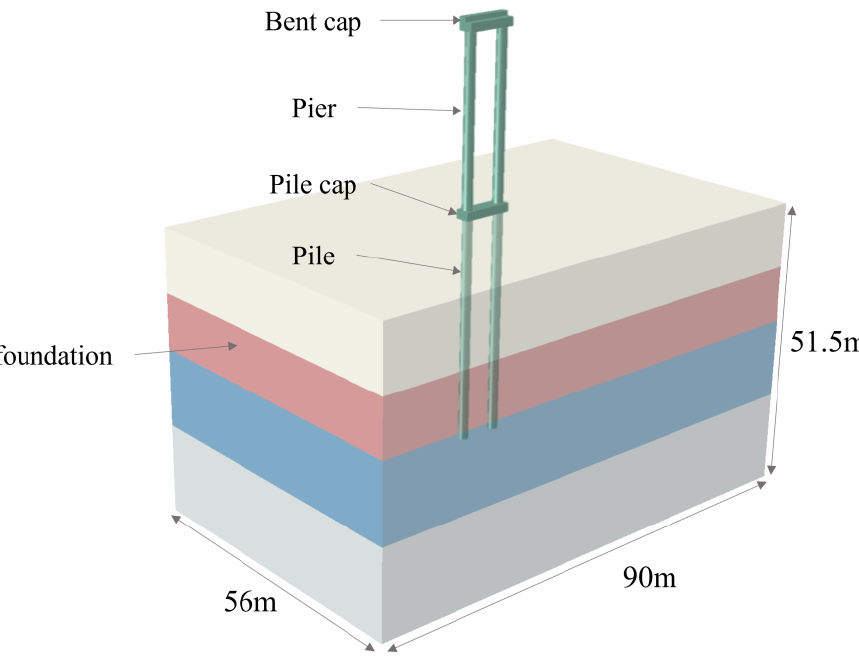
Figure 18. Abaqus model considering soil